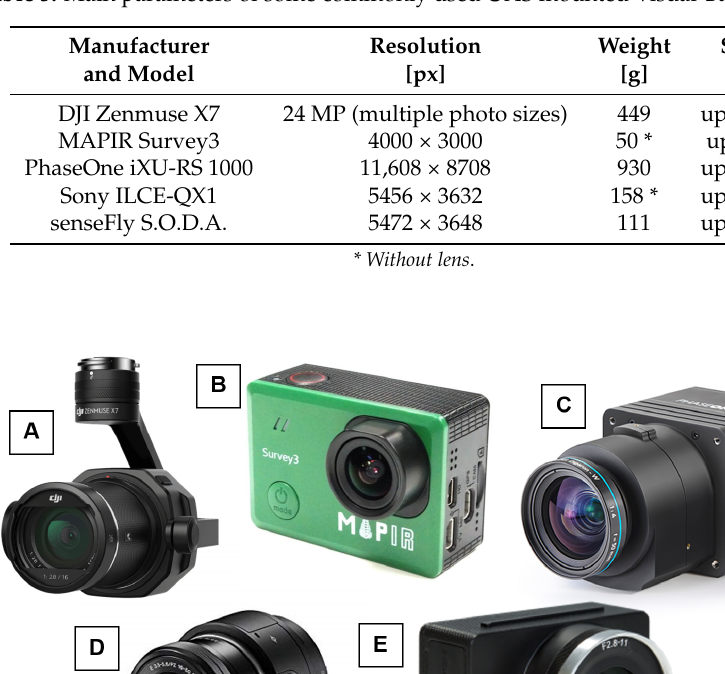
Table 3. Main parameters of some commonly used UAS mounted Visual-Band cameras.